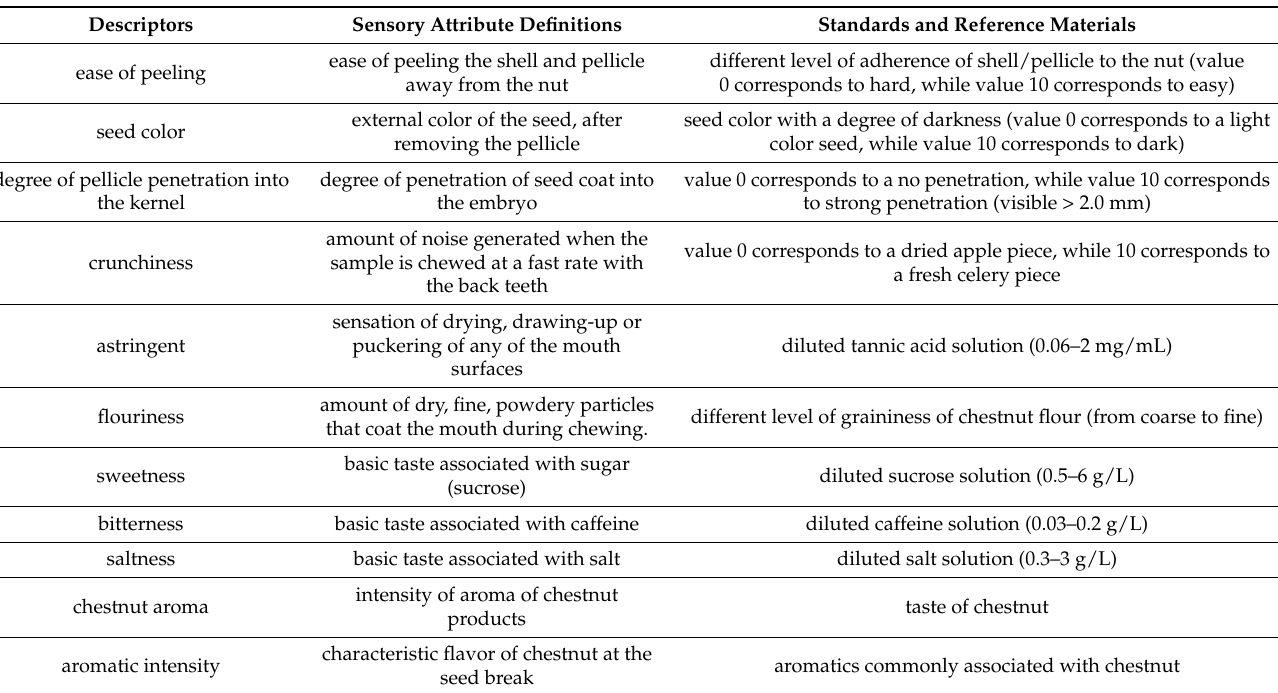
Table 1. Descriptive terms of sensory attributes and their associated reference